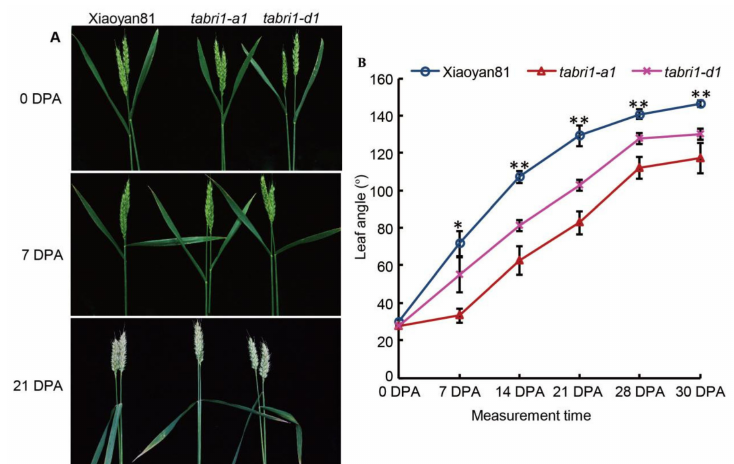
Figure 4. Kinetic comparison of leaf angle between the flag leaf blade and its sheath of WT and TaBRI1 mutants at the post-anthesis stage. ( A ) Flag leaf morphology; ( B ) leaf angle in WT and TaBRI1 mutants during the whole post-anthesis period. Each genotype had three biologic replicates, and each biologic replicate comprised fifteen plants. * and ** indicate significant di ff erences between WT and TaBRI1 mutants at p < 0.05 and p < 0.01, respectively.